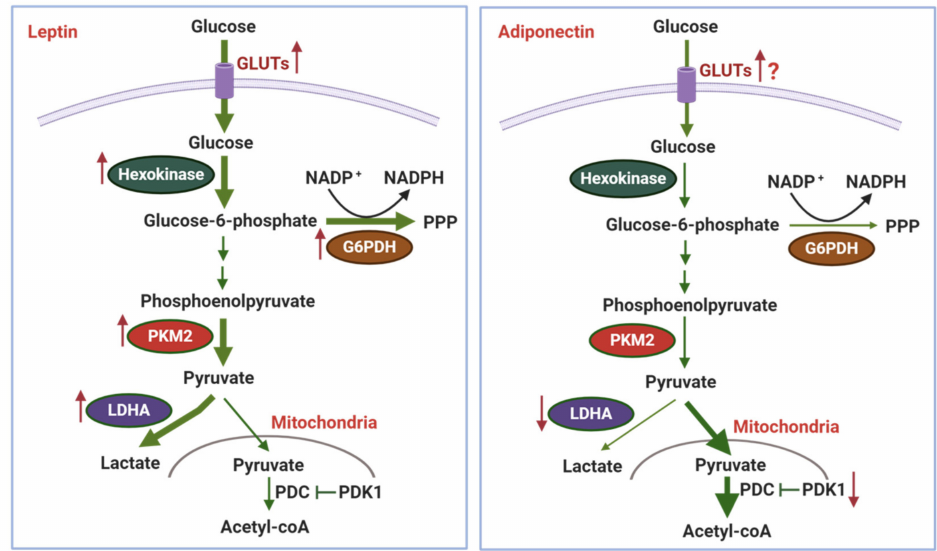
Figure 1. The modulatory effects of leptin and adiponectin on glucose metabolism in cancer cells. Glucose metabolism is profoundly remodeled in tumor cells, characterized by upregulation of glucose uptake and glycolytic pathway. Leptin promotes glycolysis by elevating expression and membrane translocation of glucose transporters (GLUTs), as well as increased expression of key enzymes in this pathway, including hexokinase, the M2 isoform of pyruvate kinase (PKM2), and lactate dehydrogenase A (LDHA). In addition, leptin increases expression of glucose-6-phosphate dehydrogenase (G6PDH), leading to upregulation of pentose phosphate pathway (PPP) for generat- ing nicotinamide adenine dinucleotide phosphate (NADPH), pentose, and ribose-5-phosphate. In contrast, adiponectin appears to counteract the Warburg effect. Through activation of AMP-activated protein kinase (AMPK), it is assumed that adiponectin downregulates LDHA to inhibit the produc- tion of lactate from pyruvate but also reduces expression of pyruvate dehydrogenase kinase 1 (PDK1), a suppressor of pyruvate dehydrogenase complex (PDC), to increase the conversion of pyruvate to acetyl-CoA. Enlarged arrows denote the metabolic pathways activated by